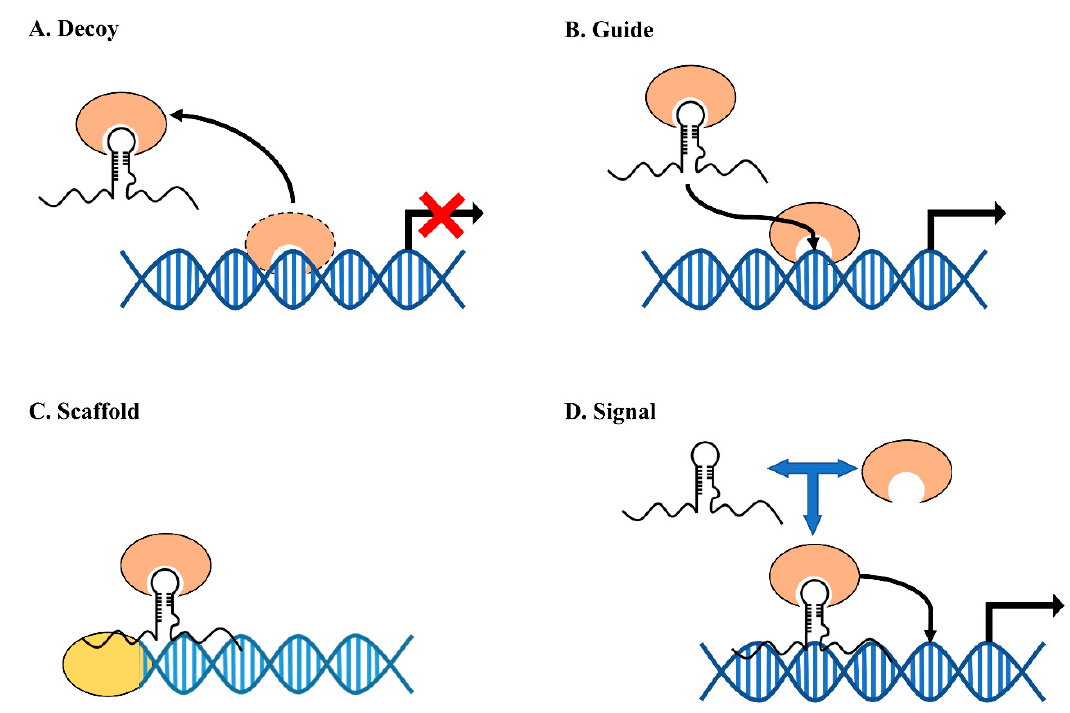
Figure 8. Schematic diagram of mechanisms of lncRNAs: ( A ) lncRNAs working in decoy mechanism can prevent the binding of a molecular to its target; ( B ) lncRNAs working in guide mechanism can direct the lncRNA-interacting molecules to specific genes or loci; ( C ) lncRNAs working in scaffold mechanism serve as central platforms for the binding of multiple molecules; and ( D ) lncRNAs working in signal mechanism can serve as ”switches” for the activation of specific genes.